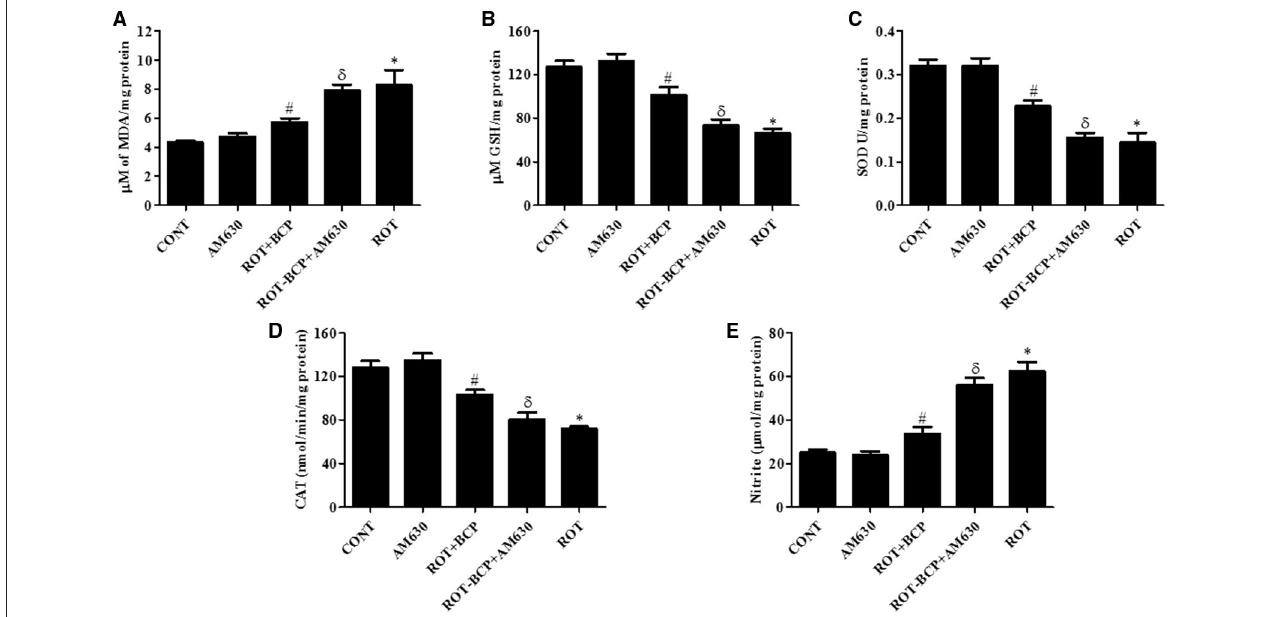
FIGURE 4 | The levels of malondialdehyde (MDA), glutathione (GSH), superoxide dismutase (SOD), catalase (CAT), and nitrite in the midbrain tissue. Values are expressed as mean ± SEM ( n = 6–8). ROT treatment caused significant (* p < 0.01) increase in MDA (A) and decrease in GSH level (B) in ROT challenged rats as compared to vehicle injected control (CONT) rats. BCP treatment of ROT challenged rats showed significantly (# p < 0.05) decreased level of MDA and increased (# p < 0.01) GSH level. However, CB 2 antagonist AM630 administration prior to BCP treatment to ROT challenged rats significantly ( δ p < 0.05) augmented the level of MDA and GSH as compared to ROT + BCP group rats. The activity of the antioxidant enzymes: SOD (C) and CAT (D) was significantly (* p < 0.05) decreased and nitrite (E) level was increased in the ROT group rats as compared to CONT group rats. BCP treatment of ROT administered ROT + BCP group rats significantly (# p < 0.05) augmented the SOD and CAT activity and nitrite level in comparison to the ROT group. ROT-BCP + AM630 group rats showed significant ( δ p < 0.05) decline in SOD and CAT activity and rise in nitrite level as compared to ROT + BCP group